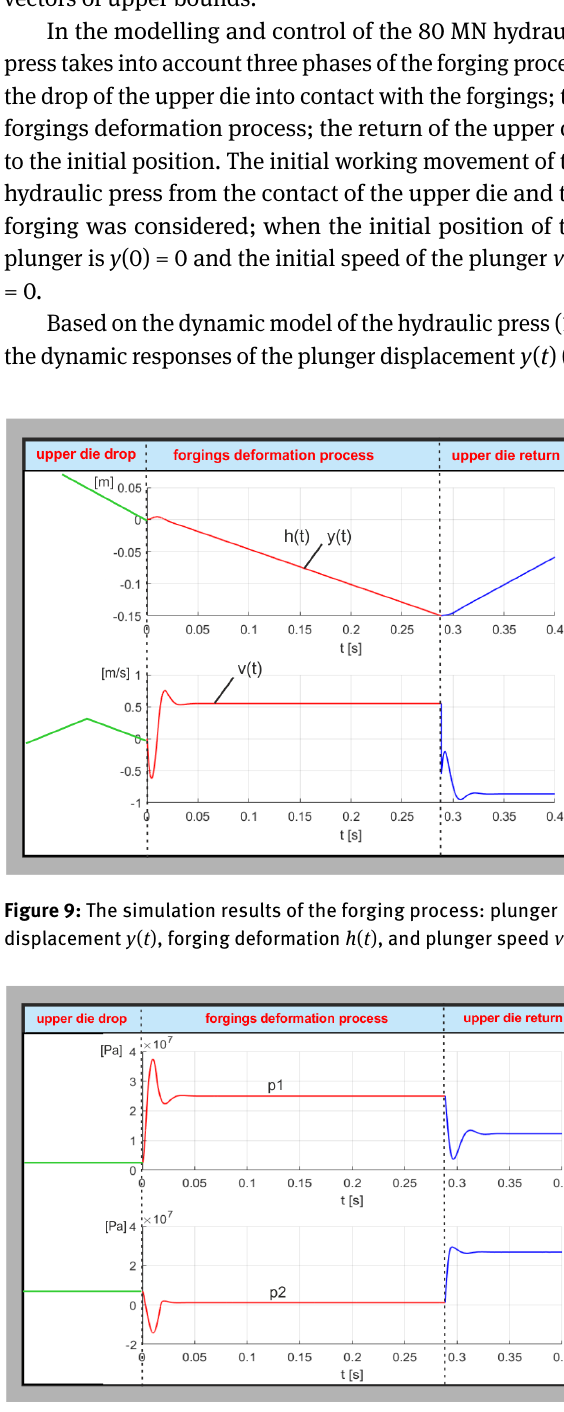
Figure 10: The simulation results of the forging process: working pressure p 1 ( t ) and return pressure p 2 ( t ) in the press